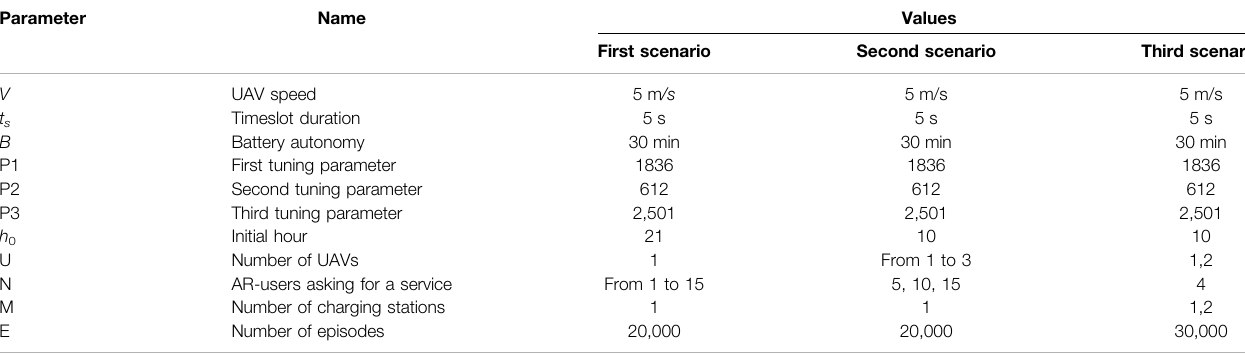
TABLE 1 | Scenario parameters used in the